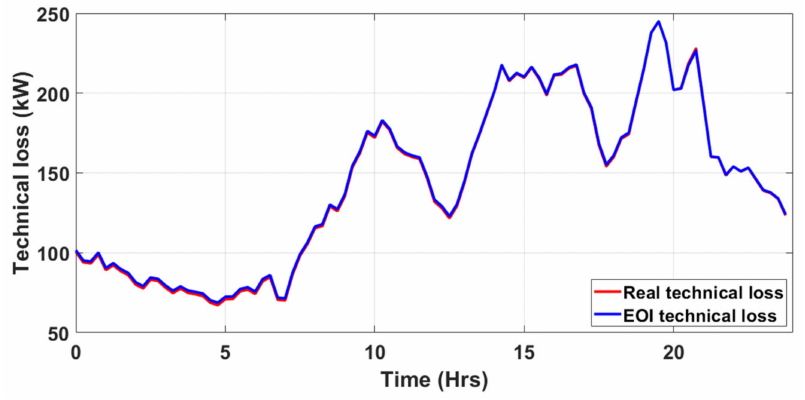
Figure 10. Real technical loss (red) and technical loss calculated using EOI